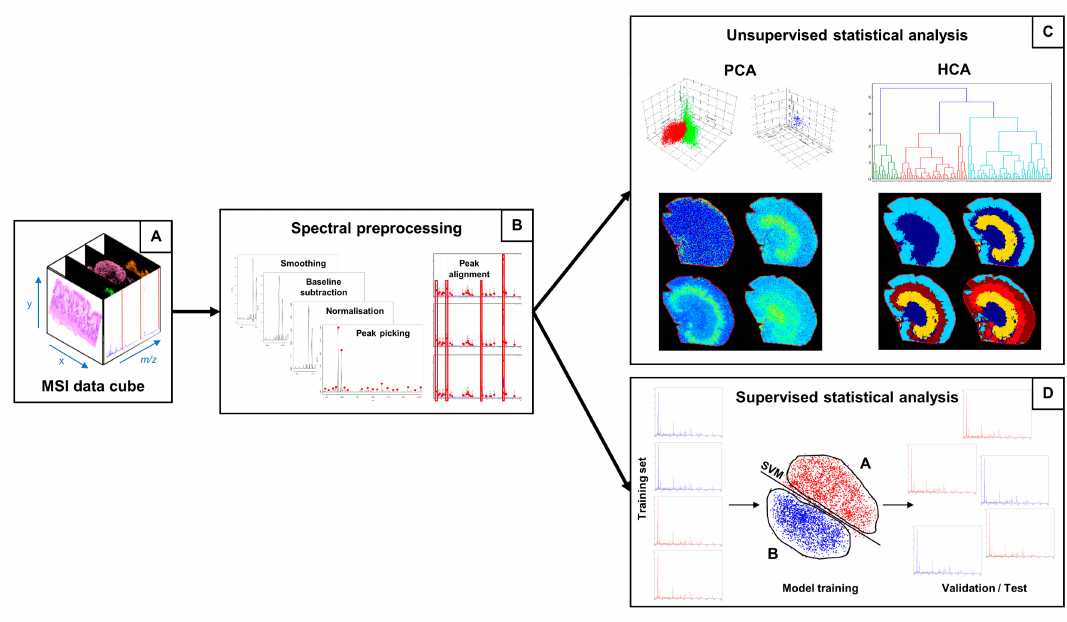
Figure 2. A schematic overview of the MSI data elaboration workflow. ( A ) Data cube; ( B ) the series of spectra pre-processing steps; ( C ) unsupervised and ( D ) supervised statistical analysis performed on a spectra dataset. MSI, mass spectrometry imaging; PCA, principal component analysis; HCA, hierarchical clustering analysis; SVM, support vector